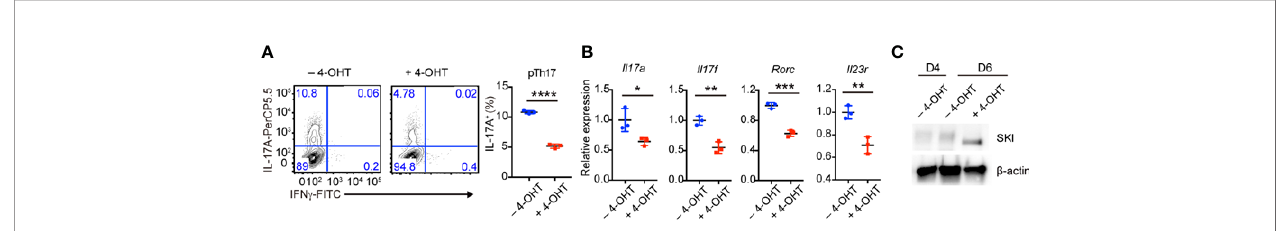
FIGURE 4 | Induced SKI expression disrupted the in vitro maintenance of pathogenic Th17 cells. (A) Flow-cytometry of IFN g - or IL-17A-producing pTh17 cells from SKI-ER mice treated with or without 4-hydroxytamoxifen (4-OHT). The pTh17 cells were fi rst generated under pTh17 polarizing conditions for four days and 4- hydroxytamoxifen (4-OHT) was added for another four days. Left, representative plot; right, composite data from 3 mice per group of three independent experiments; means ± s.d., ****p < 0.0001, by two-sided Student ’ s t -test. (B) The mRNA expression of Il17a , Il17f , Rorc and Il23r in pTh17 cells as in (A) . The pTh17 cells were fi rst generated under pTh17 polarizing conditions for four days and 4-hydroxytamoxifen (4-OHT) was added for another two days. Relative expression levels were measured by quantitative real-time RT-PCR and were normalized to actin expression level using the standard curve method. The data were from n = 3 mice per group of three independent experiments; means ± s.d., *p < 0.05, **p < 0.01, ***p < 0.001, by two-sided Student ’ s t -test. (C) Immunoblot analysis of SKI and b -actin in SKI-ER pTh17 cells at days 4 and 6 treated with or without 4-hydroxytamoxifen (4-OHT). The images were representative of three independent